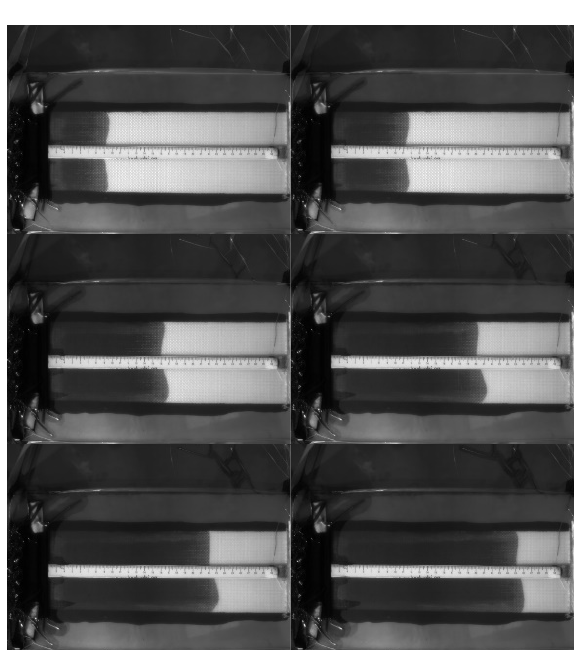
Figure 14. Flow visualization of RTM using a seven ‐ layer fiber preform: images captured at the 50th, 100th, 150th, 200th, 250th, and 300th second.